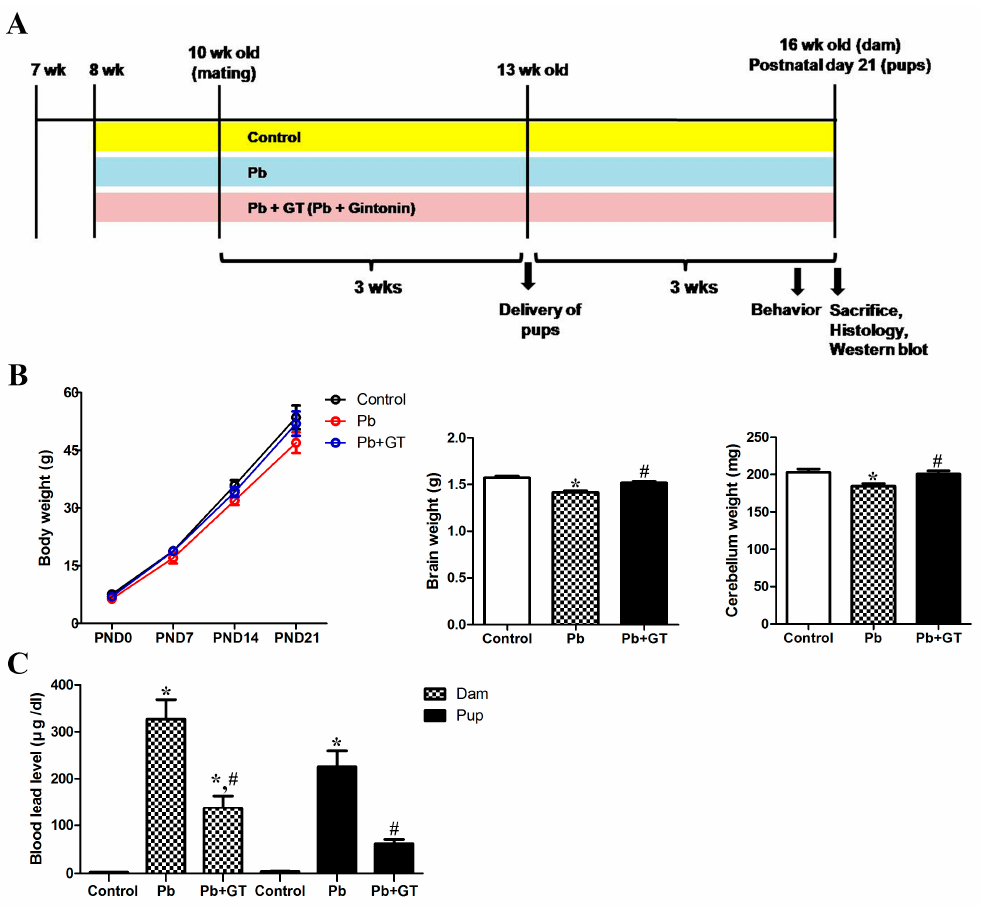
Figure 1. Experimental design and physiological changes after Pb alone or gintonin plus Pb. ( A ) The present study was performed as shown in the experimental design. ( B ) Body weights of dams (n = 3 per group) during gestation and o ff spring (n = 12 per group) on postnatal days (PND) 0, 7, 14, and 21 in the control, Pb, and Pb plus gintonin (Pb + GT) groups (body weight, p = 0.9676, one-way analysis of variance). Whole-brain and cerebellar weights of o ff spring on PND21 (wet brain weight, p < 0.0001, one-way analysis of variance; wet cerebellar weight, p = 0.0080, one-way analysis of variance). ( C ) Blood Pb levels in the dams and o ff spring PND21 (blood Pb level, p < 0.0001, one-way analysis of variance). * p < 0.05, compared to control group, # p < 0.05, compared to Pb alone, Tukey’s post-hoc test. The bars indicate means ± standard error of